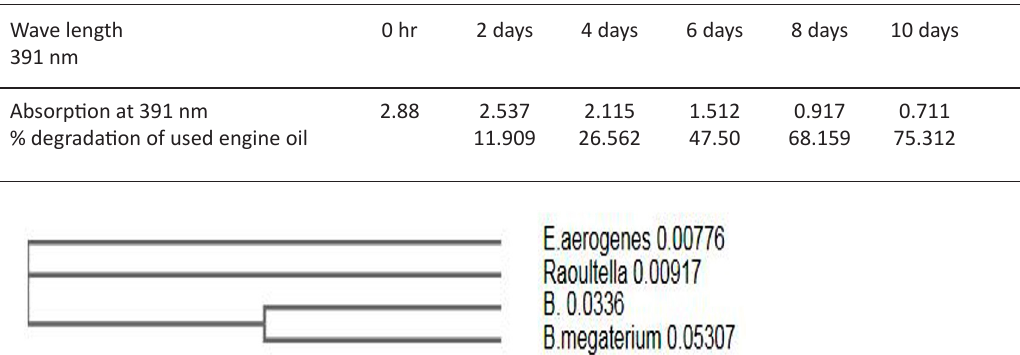
Table 1. Percentage degradation of used engine oil with consortium adsorbed bioreactor at different incubation time